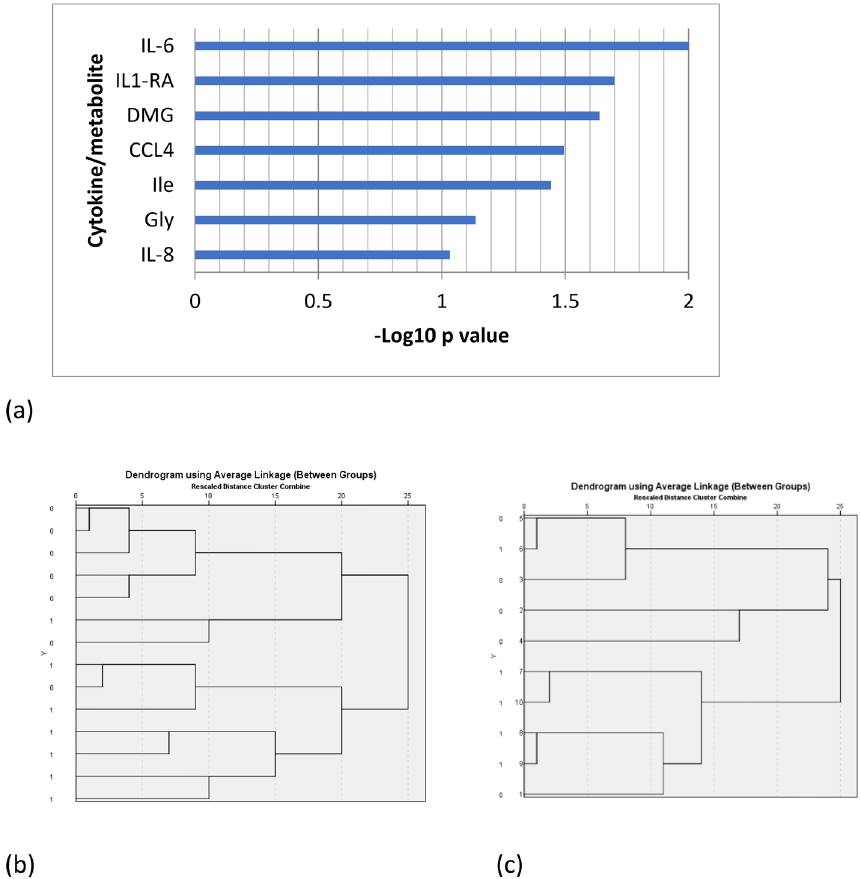
Figure 5. Candidate signature molecules were ranked for their potential patients/control discriminant capacity on the basis of the p-values of the difference between their concentration in patients and control groups (-Log10 p-values). ( a ). The discriminant power of the candidate signature was evaluated using hierarchical clustering in serum samples ( b ). Hierarchical clustering was applied also to tissue samples, using the 5 candidate molecules expressed also in tissue (IL-6, CCL4, IL1-ra, Gly and IL-8) ( c ). Figure produced by Metaboanalyst Version 4.0 (https:// www. metab oanal yst. ca) and Microsoft Excel, Office Professional Plus 2019 (http:// www. office. com). No permission